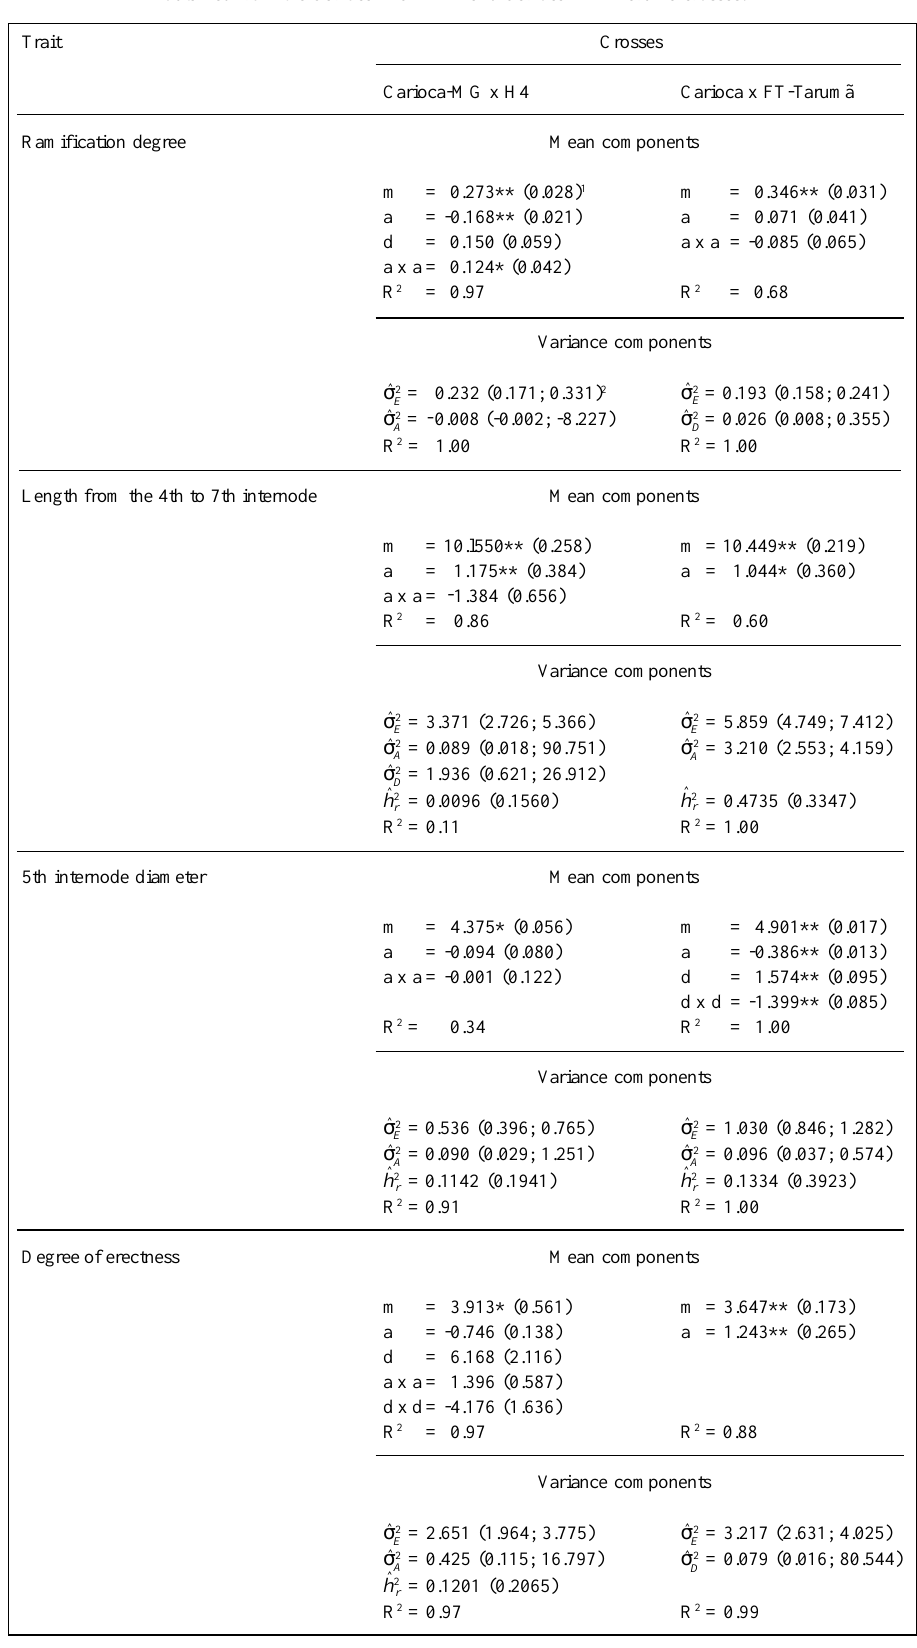
Table III - Estimates of mean and variance components for some traits related to bean plant architecture obtained from the Carioca-MG x H-4 and Carioca x FT-Tarumã crosses.